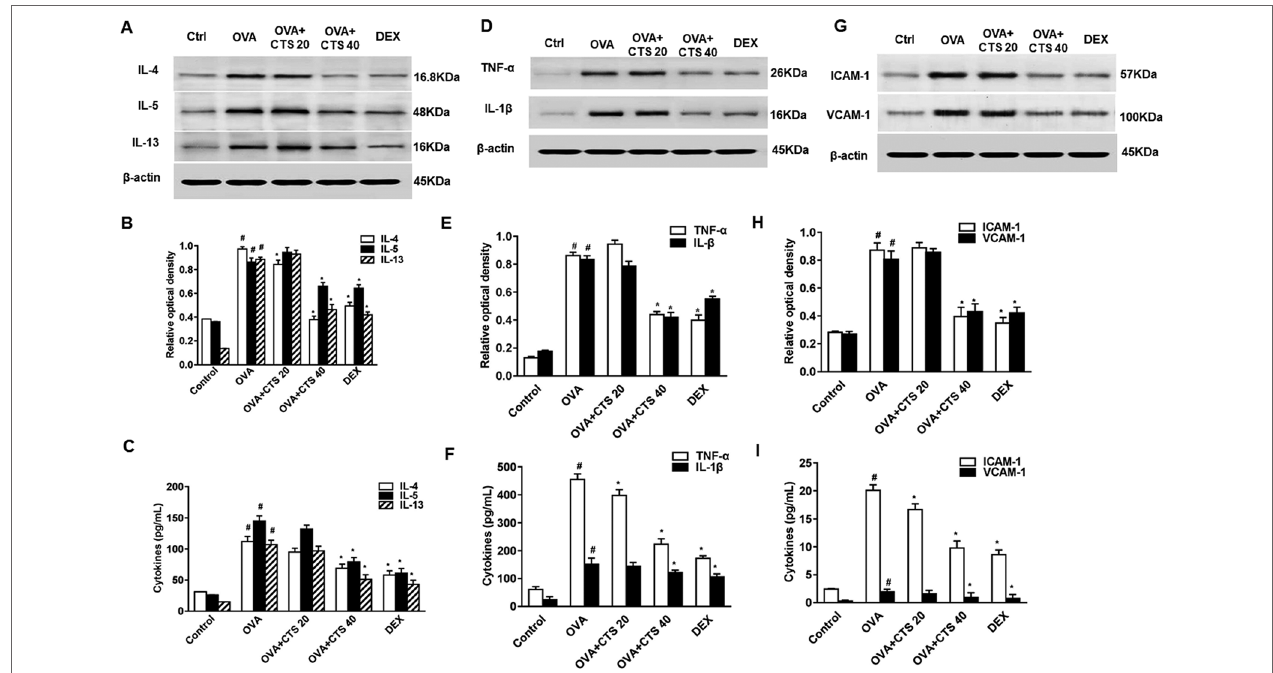
FIGURe 2 | Effect of cryptotanshinone (CTS) on ovalbumin (OVA)-induced cytokines elevation and assessment of immunoglobulin E (IgE). (A , D , and G) The levels of interleukin 4 (IL-4), IL-5, IL-13, IL-1β, tumor necrosis factor alpha, intercellular cell adhesion molecule-1, and vascular cell adhesion molecule 1 in lung tissues were detected by Western blot. (B , e , and h) Densitometric analysis was presented as the relative ratio of each molecule to β-actin. The relative ratio of each molecule in the lung tissues of untreated mice is arbitrarily presented as 1. (C , F , I) The levels of cytokines, total and OVA-specific IgE in bronchoalveolar lavage fluids supernatant from each group were detected by ELISA. Data were shown as mean ± SEM (n = 8). #P < 0.05 vs. untreated mice; *P < 0.05 vs. OVA-treated mice. Control (PBS-inhaled mice administered with PBS), OVA (OVA-inhaled mice administered with PBS), OVA+CTS 20/40 (OVA-inhaled mice administered with 20 mg/kg or 40 mg/kg CTS), and dexamethasone (DEX) (OVA-inhaled mice administered with